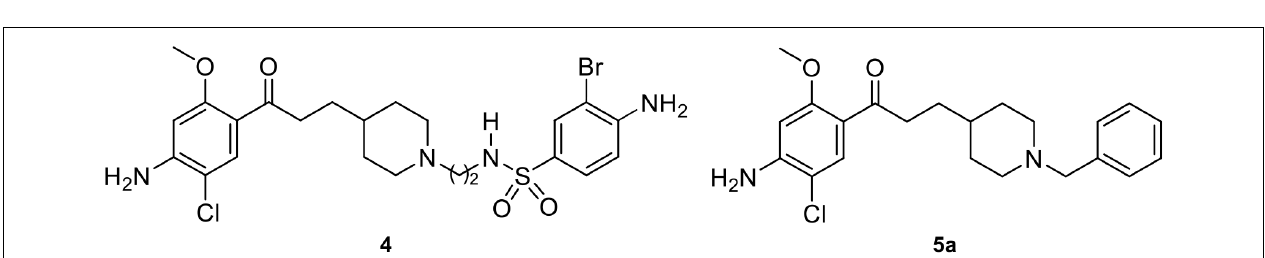
FIGURE 2 | Structure of compounds 4 and 5a